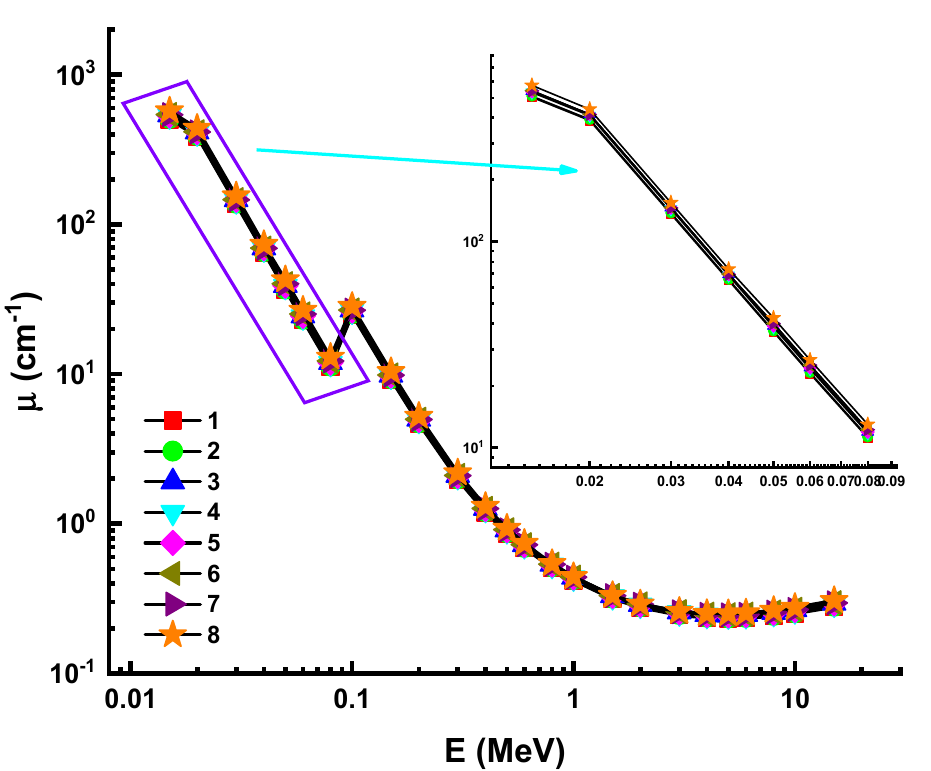
Figure 1. Variation of linear attenuation coefficient ( µ ) against Photon energy for all glasses. In Figure 1, a fast drop of 0.015 MeV to 0.08 MeV was observed. As was the case with the first field, a smooth decrement was observed in the second, demonstrating Compton scattering’s supremacy. Our results indicate that for the measured Sample 8, the highest values were discovered. This can be explained by the Eu reinforcement (Z = 63) amount in Sample 8. As is seen in Table 1, Eureinforced Sample 8 has almost the maximum glass density (i.e., 6.328 g/cm 3 ). This is due to the higher atomic number of Eu compared to other additive types such as Al, Y, Nd, and